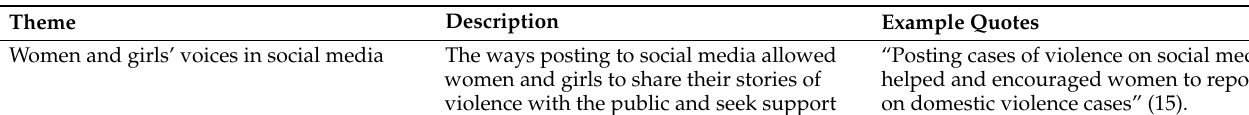
Table 1. Emerging themes and example